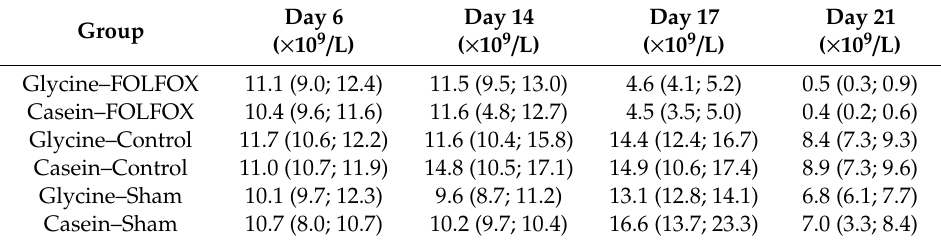
Table 2. Median white blood cell count at di ff erent time points of the study.